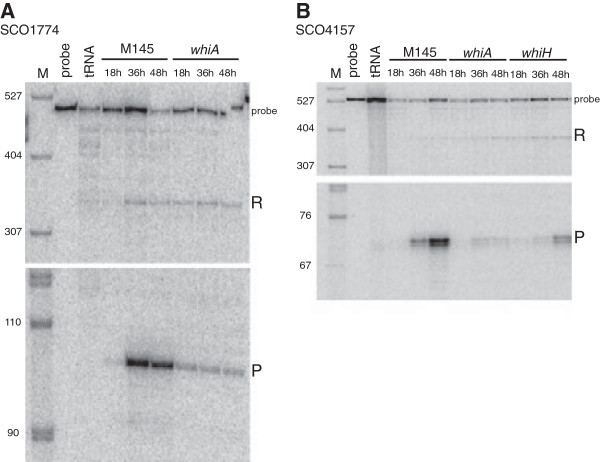
Transcription of SCO1774 and SCO4157 during development of S. coelicolor, analysed by S1 nuclease protection. A. Transcription of SCO1774 in parent strain M145 and J2401 (whiA mutant). B. Transcription of SCO4157 in the parent strain M145, J2401 (whiA mutant) and J2408 (whiH mutant). M marks a lane with a DNA size marker (sizes given in bp). A lane containing a diluted sample of the probe, and another lane with a control reaction with yeast tRNA are indicated. Fragments corresponding to putative transcription start points just upstream of SCO1774 and SCO4157 are indicated by “P”. “R” indicates read-through transcription and “probe” indicates probe-probe reannealing products.